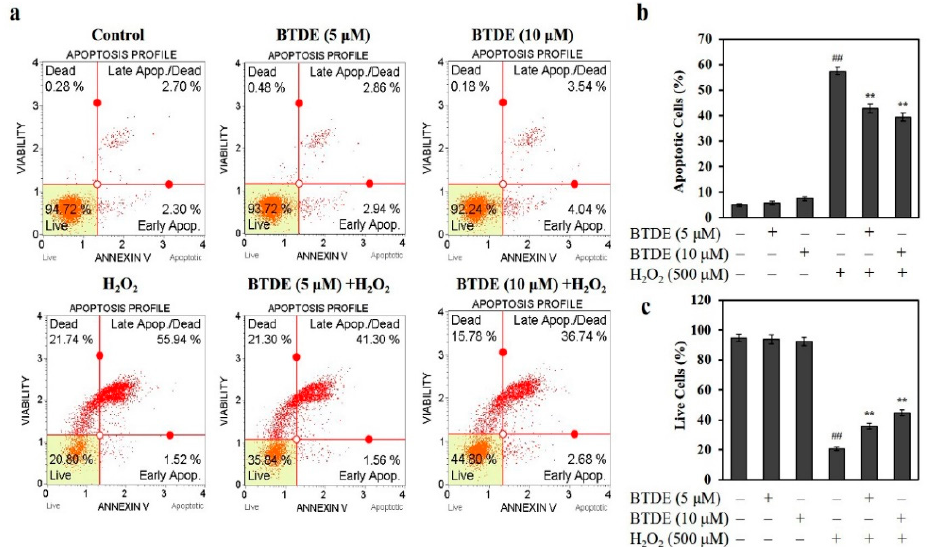
Figure 3. BTDE affects H 2 O 2 -induced HaCaT cell apoptosis and necrosis. ( a ) In the presence or absence of H 2 O 2 , the ratio of apoptosis of HaCaT cells treated with BTDE (5 and 10 µ M) was measured with a MUSE cell analyzer. ( b ) The bar graph depicts the percentage of apoptotic HaCaT cells induced by H 2 O 2 in the absence or presence of BTDE. ( c ) The bar graph depicts the percentage of surviving HaCaT cells induced by H 2 O 2 in the absence or presence of BTDE. Values are expressed as the mean ± SD of three independent experiments. ## p < 0.01, versus control group, ** p < 0.01, versus H 2 O 2 alone.